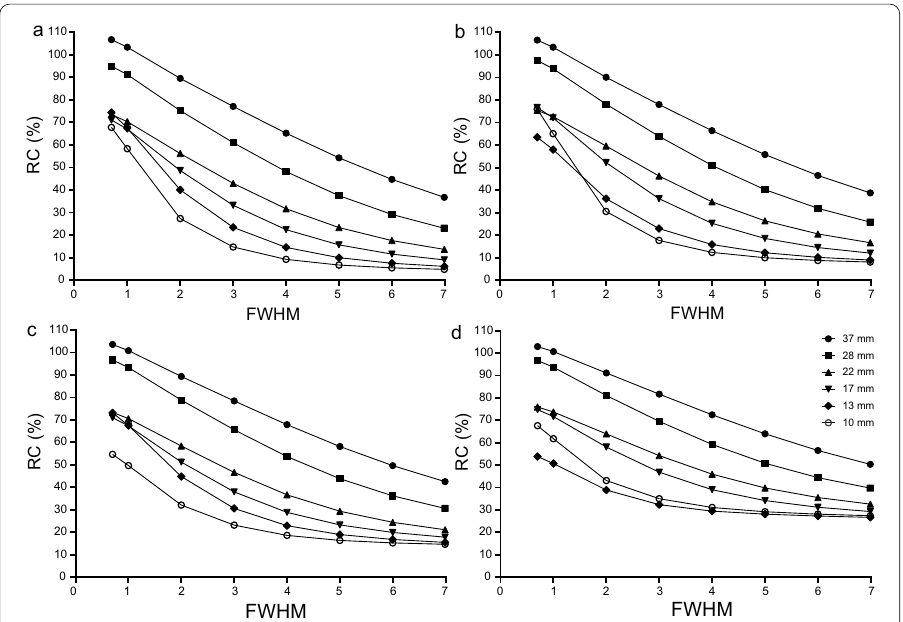
Fig. 4 Impacts of FWHM value of the Gaussian filter on RCs. a 32:1 T/B ratio; b 16:1 T/B ratio; c 8:1 T/B ratio; d 4:1 T/B ratio; RCs were calculated with FWHM value of 0.70–6.99; Fixed reconstruction parameters: 35 iterations, 20 subsets, AC SC RR combination; Fixed acquisition parameters: 120 s/frame of acquisition + + time, 15% energy window